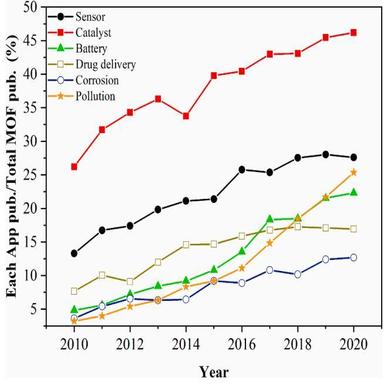
The number of studies conducted, in different fields, as a percentage of the total MOF-related publications (data was extracted from ScienceDirect website by searching the keyword "metal organic framework + desired application").